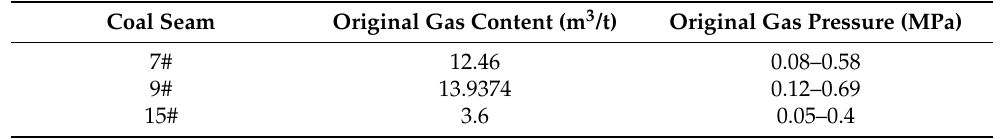
Table 1. Gas parameters of the 7#, 9#, 15# coal seams.